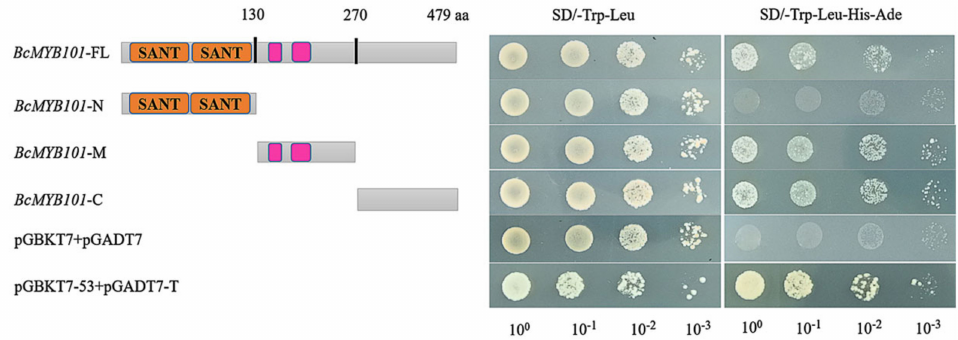
Figure 7. Trans-activation activity analysis of BcMYB101. Transcription activity assay of BcMYB101 in yeast. BcMYB101 -FL, BcMYB101 -N, BcMYB101 -M, and BcMYB101 -C represent the full-length protein,